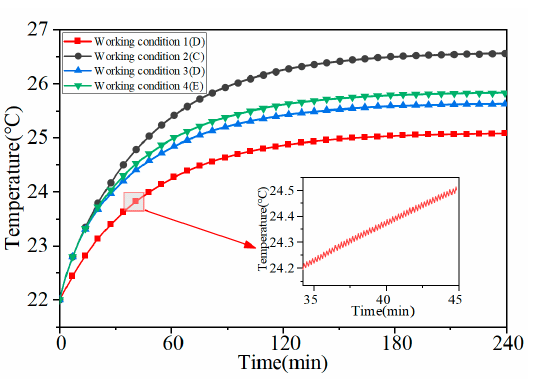
Figure 12. Location of temperature nodes.